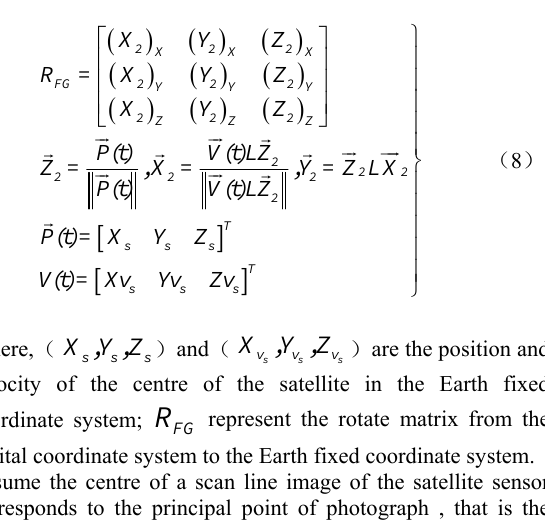
Figure 2. The technical route of optimal imaging decision